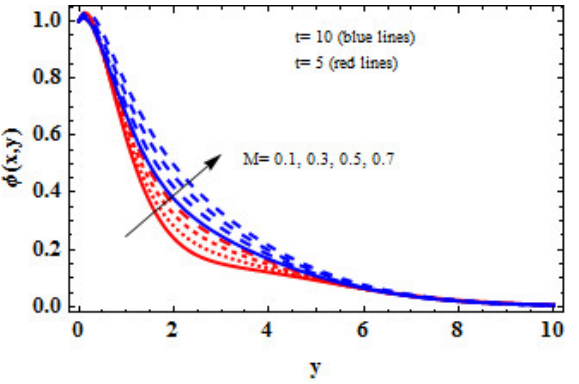
Figure 10. M effect on concentration with respect to time.